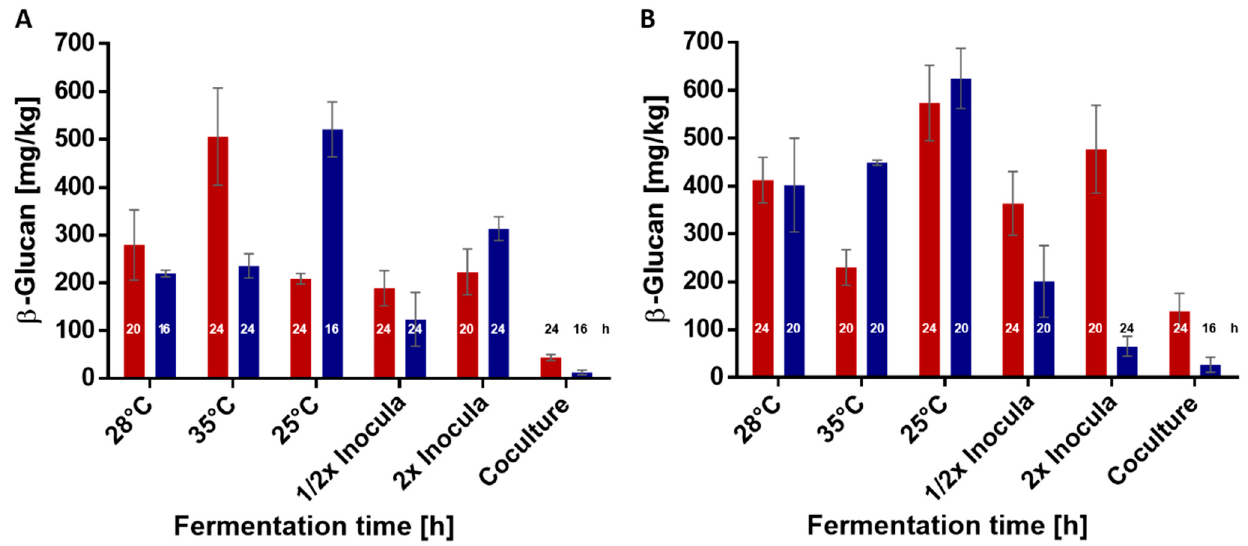
Figure 3. Maximal β -glucan concentrations in fermented wheat and rye sourdoughs under different conditions. ( A ) L. brevis TMW 1.2112 ( ▋ ) and P. claussenii TMW 2.340 ( ▋ ) in wheat sourdough and ( B ) L. brevis TMW 1.2112 and P. claussenii TMW 2.340 in rye sourdough with the respective fermentation times in h. Values are means of biological triplicates including standard deviations.